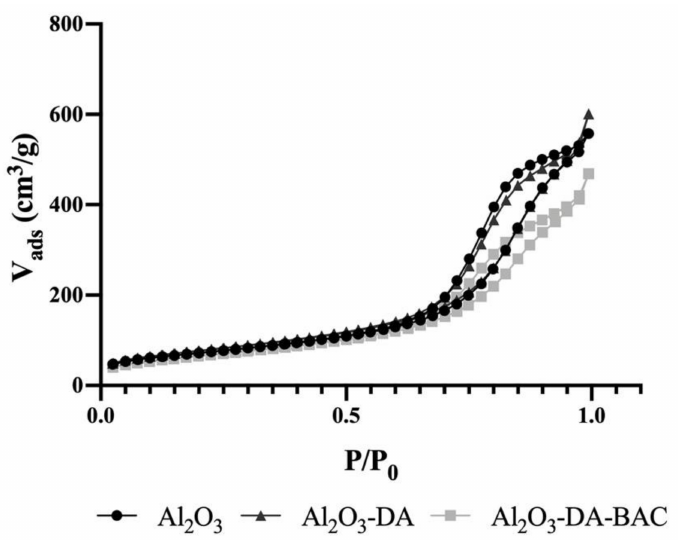
Figure 2. Nitrogen adsorption and desorption isotherms of functionalized and Al 2 O 3